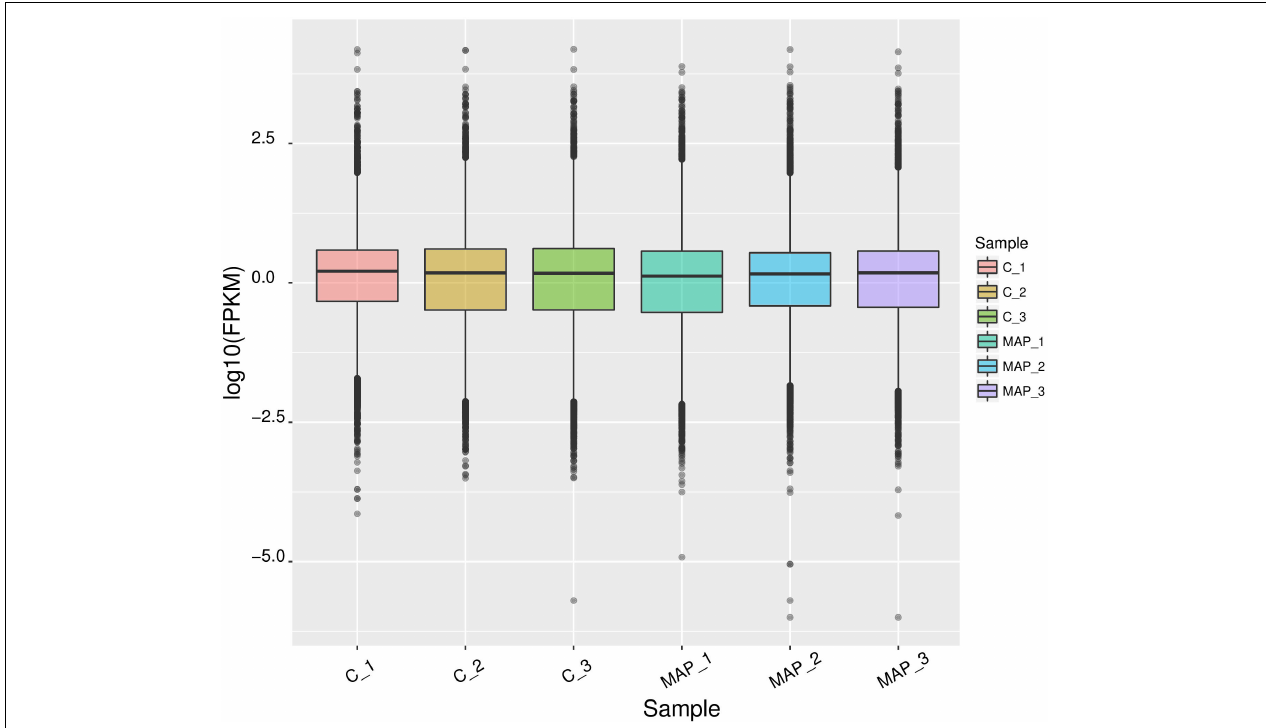
FIGURE 2 | Statistical map of gene expression value distribution of each sample. The abscissa is the sample name, the ordinate is log10 (FPKM), and the box chart of each region corresponds to five statistics (maximum, upper quartile, median, lower quartile, and minimum from top to bottom).